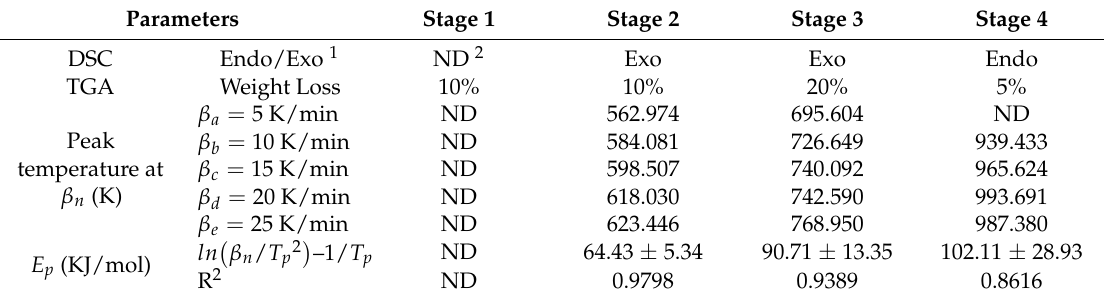
Table 3. Thermal characteristics of upstream oily sludge in stages one through